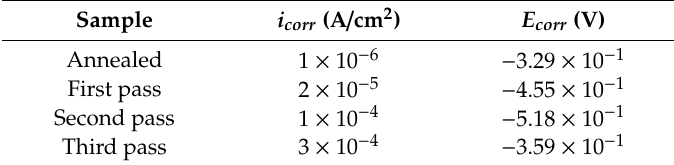
Table 1. Potentiodynamic polarization results in the 3.5% NaCl Solution.